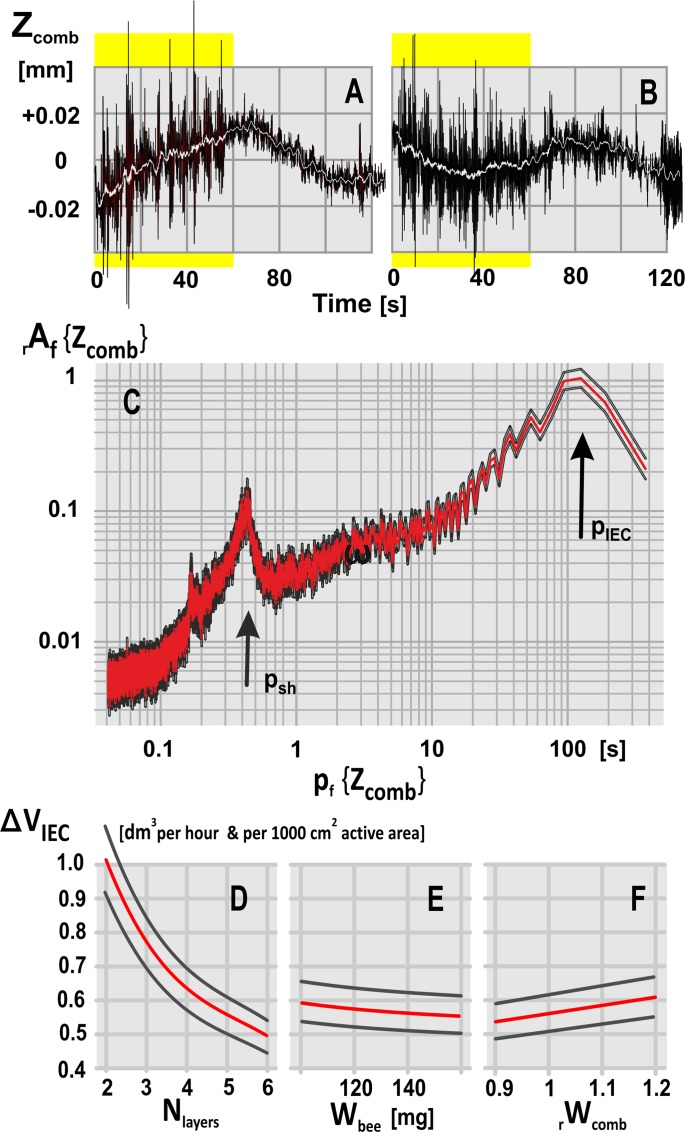
Comb dislocations in a giant honeybee nest during shimmering and quiescence.(A-B) Two LDV records of comb dislocations (Zcomb; cf [30], scaled in mm/s; see Methods and S3 Fig). Black curves, unfiltered data; white superposed curves give low-frequency components defined as moving average values (±50 frames with interframe intervals of Δtff = 20 ms); yellow background marks the first 60 s of observation, in which shimmering waves had been provoked by dummy wasp presentation [30]. (C) FFT-diagram: abscissa, the periods of partial frequency components of comb dislocations p {Zcomb} in s; ordinate, the relative amplitude of these frequency components rAf {Zcomb}. The period of the main low-frequency component presumably caused by “inhalation / exhalation cycling” (IEC) was assessed at pf {Zcomb} = pIEC = 109.96 s (marked by the black arrow in panel C), as compared to psh, the period of oscillation provoked by shimmering (cf. [30]); (D-F) Mathematical model estimating the hourly change in volume of gas exchange affected by IEC according to the ventilation hypothesis (ordinate: ΔVIEC [dm3 h-1]). In this model, the size of the nest area affected by ventilation was chosen as 1 000 cm2 corresponding to an area with a radius of 17.85 cm around the respective CNR funnel. The volume of gas exchange is dependent on three mass parameters of the bee curtain (number of bee layers Nlayers: panel D; individual weight of a honeybee Wbee in mg: panel E) and of the comb (the relative weight of the comb area rWcomb: panel F). Red curves, mean values; black curves, range of mean errors; nLDV = 23 LDV episodes. Normative base data (see Tables 1–3): density of bees in the bee curtain = 1 bee per cm3; density of cells at both comb sides = 787 / dm2 [72]; mass of the wax = 24.11 g dm-2 [72]; this adds up to a mass of Wcomb = 134.29 g /dm2 comb area with larvae-containing cells (corresponding with rWcomb = 1.0 in panel F).